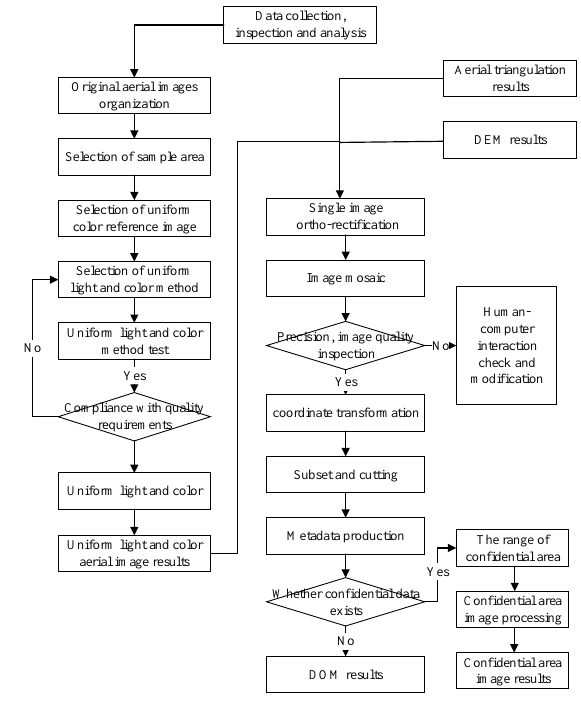
Figure 1 . The process of DOM